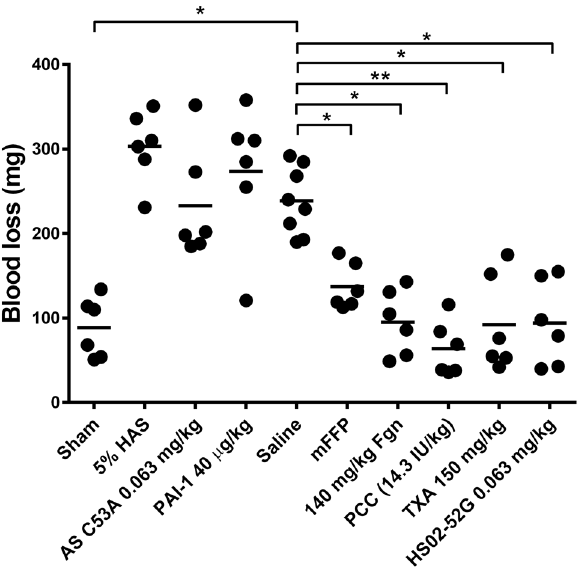
Figure 3. Blood loss following trauma, shock, resuscitation, and liver laceration in mice treated with different fluids. HS/LL mice were subjected to 60 min haemorrhagic shock (HS), then resuscitated with the resuscitation fluids and doses identified below the x-axis of each graph, equal in volume to the shed blood, prior to haemostatic challenge by liver laceration (LL). Sham mice were anaesthetized and cannulated but were not subjected to haemorrhagic shock, resuscitation, or liver laceration, but were otherwise maintained identically to protocol mice with respect to timing of sampling and handling. Each point represents a single mouse (n = 6 in all cases except n = 8 for saline). Horizontal lines within the scatter plots represent the mean of each group. Asterisks above horizontal brackets refer to statistical differences versus Saline between groups by